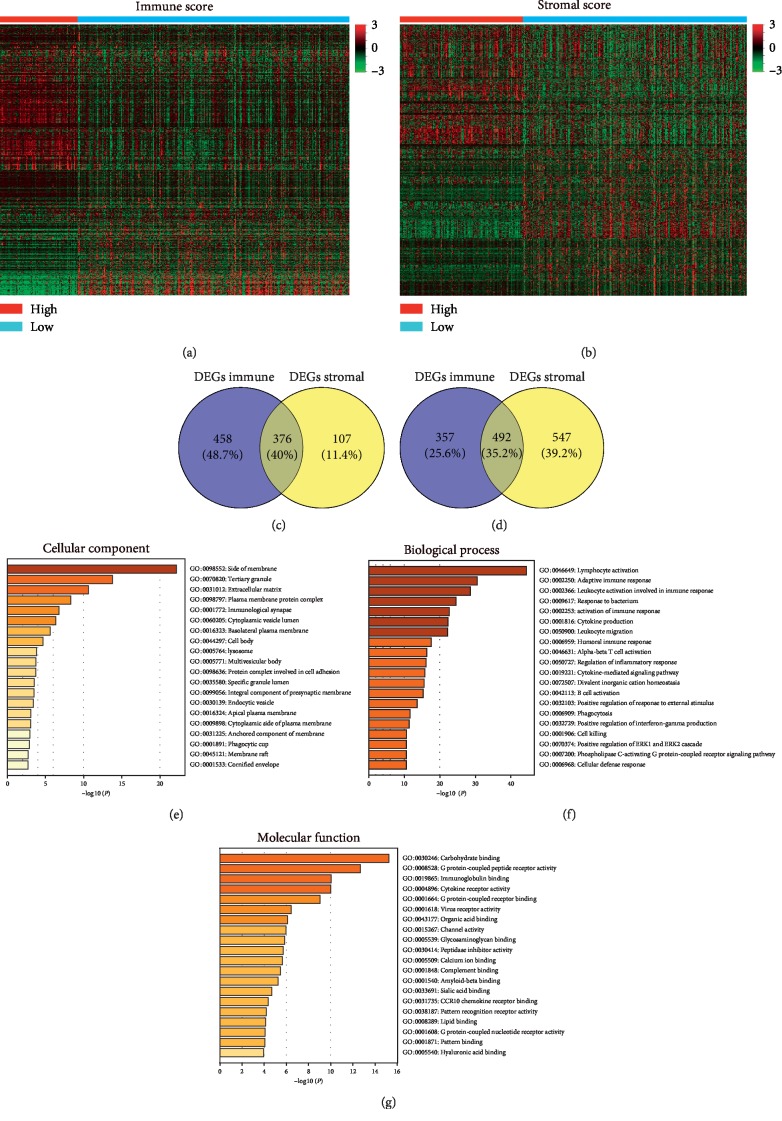
Gene expression profile is of great relevance to immune scores and stromal scores in BLCA. (a, b) Heatmaps show that differentially expressed genes profiles between high and low immune scores/stromal scores groups. Red represents higher expression genes, green represents lower expression genes, black represents same expression genes (fold change >1.5 and P < 0.05). (c, d) Venn diagrams show the number of coupregulated (c) or codownregulated (d) DEGs in immune and stromal score groups. (e, f, and g) The major relevant terms. P < 0.05.